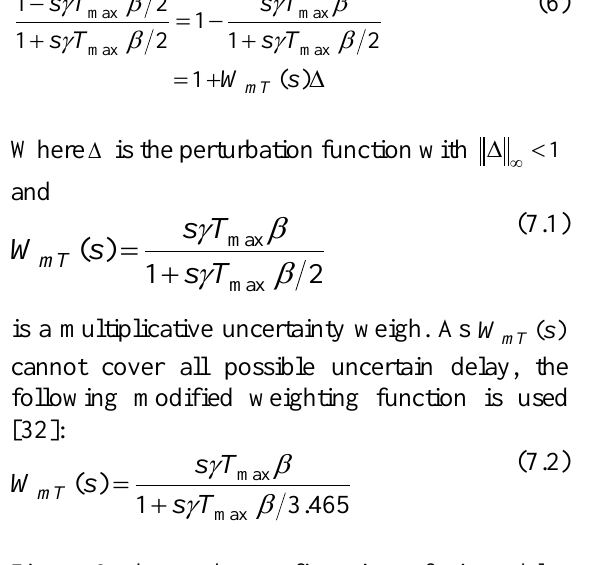
Figure 4. Standard control system